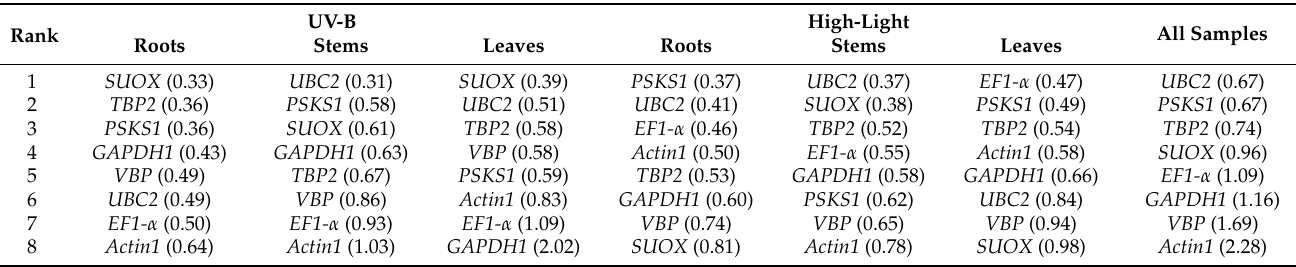
Table 2. Expression stability of eight candidate reference genes under UV-B and high-light stresses according to the BestKeeper analysis